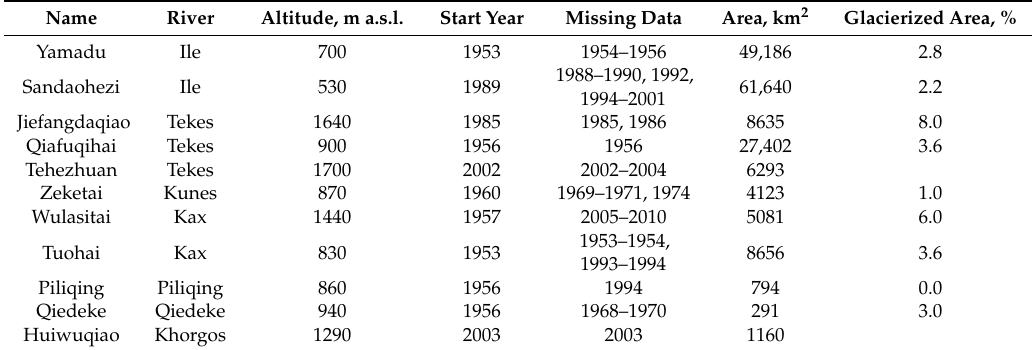
Table 1. Hydrometeorological stations in the Chinese sector of the Ile River Basin (C-IRB). Locations of the stations are shown in Figure